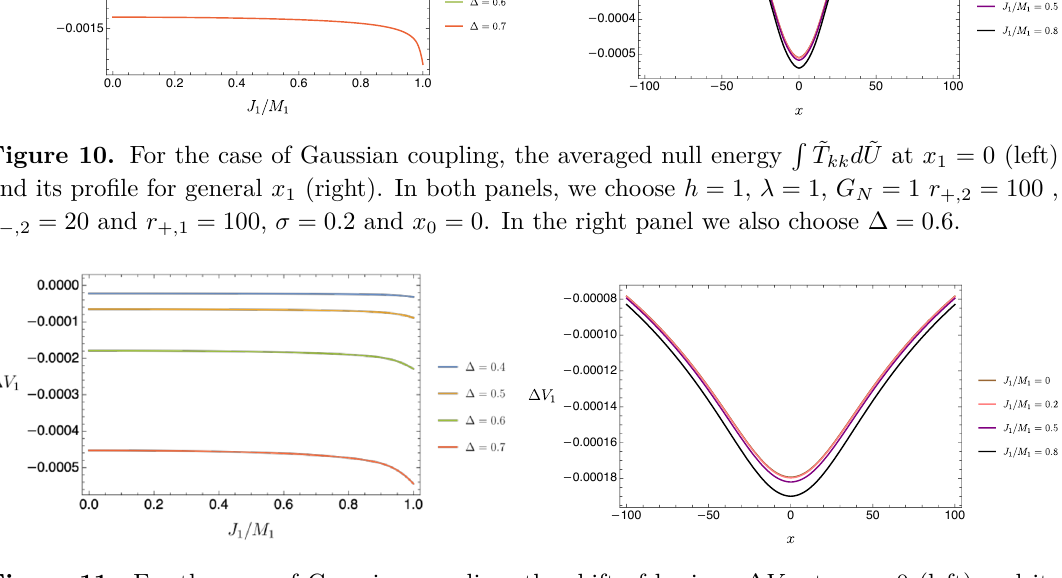
= 1 r = 100 , r = 20 N + , 2 − , 2